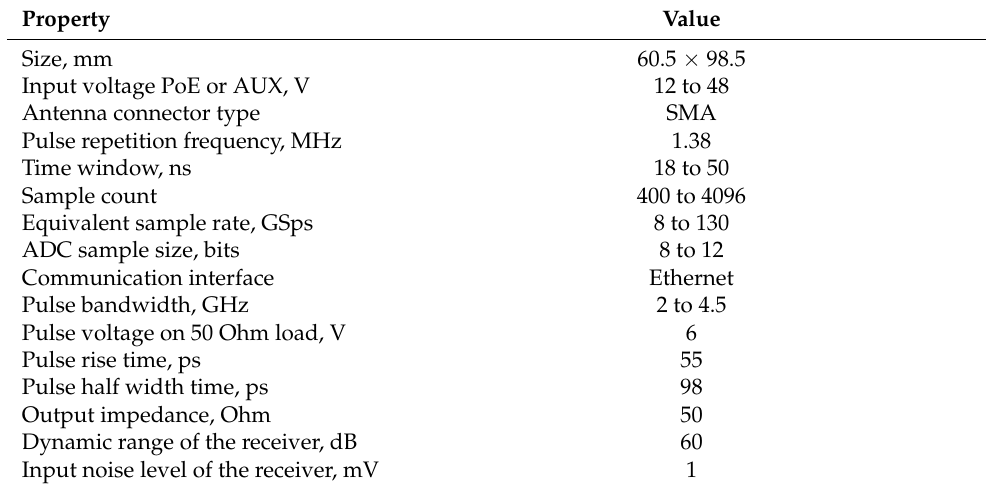
Table 1. Parameters of the upgraded